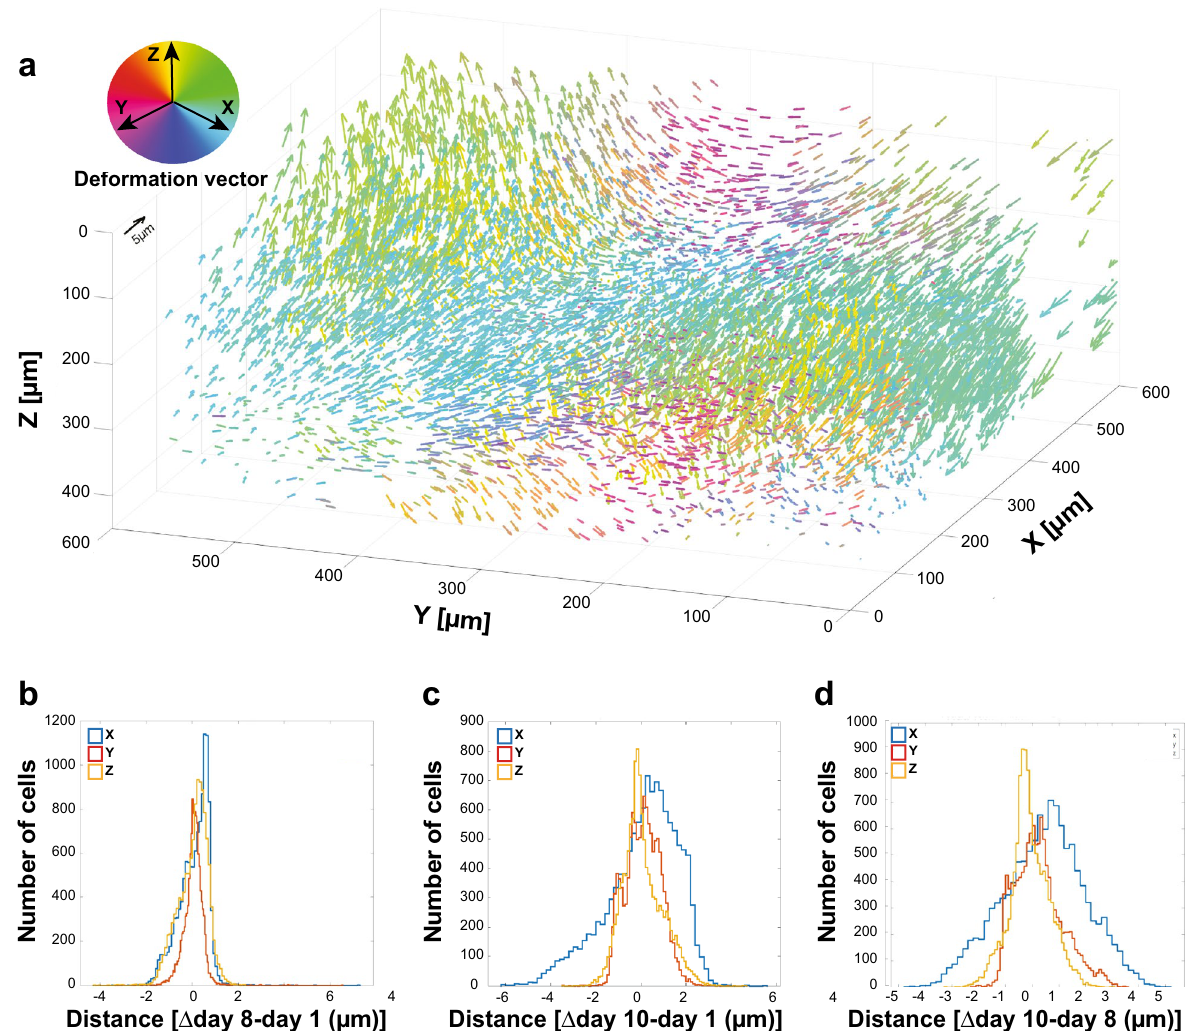
Figure 4. A cortical elasticity map assesses temporal cellular structure dynamics in vivo. ( a ) CNS cell bodies’ positional temporal changes, attributed to subtle tissue movement, between Day 1 and Day 10 of imaging as a function of the difference between rigid and elastic registration. Arrow’s color represents the spatial positional temporal changes, based on each individual cell body location change, while its length indicates the distance. ( b–d ) spatial positional temporal changes (distance) histogram of the center position offset of registered CNS cell bodies across X, Y, and Z axes between time points. The histogram shows only registered cells that were less than 10 µm apart, between ( b ) imaging Day 8 to Day 1 (76% of cells), ( c ) imaging Day 10 to Day 1 (76% of cells), and ( d ) imaging Day 10 to Day 8 (78% of